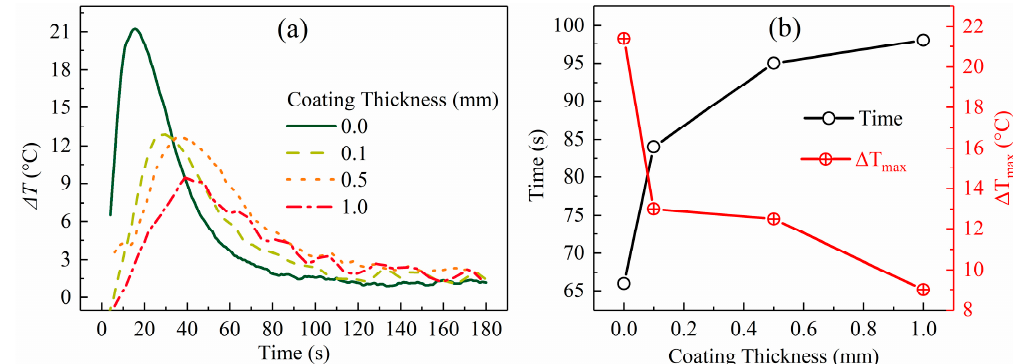
Figure 8. ( a ) Evolution of temperature difference between points 1 and 3 in Figure 5 for different coating thicknesses. ( b ) Duration of unstable stage and maximum temperature difference between points 1 and 3 in Figure 5 for different coating